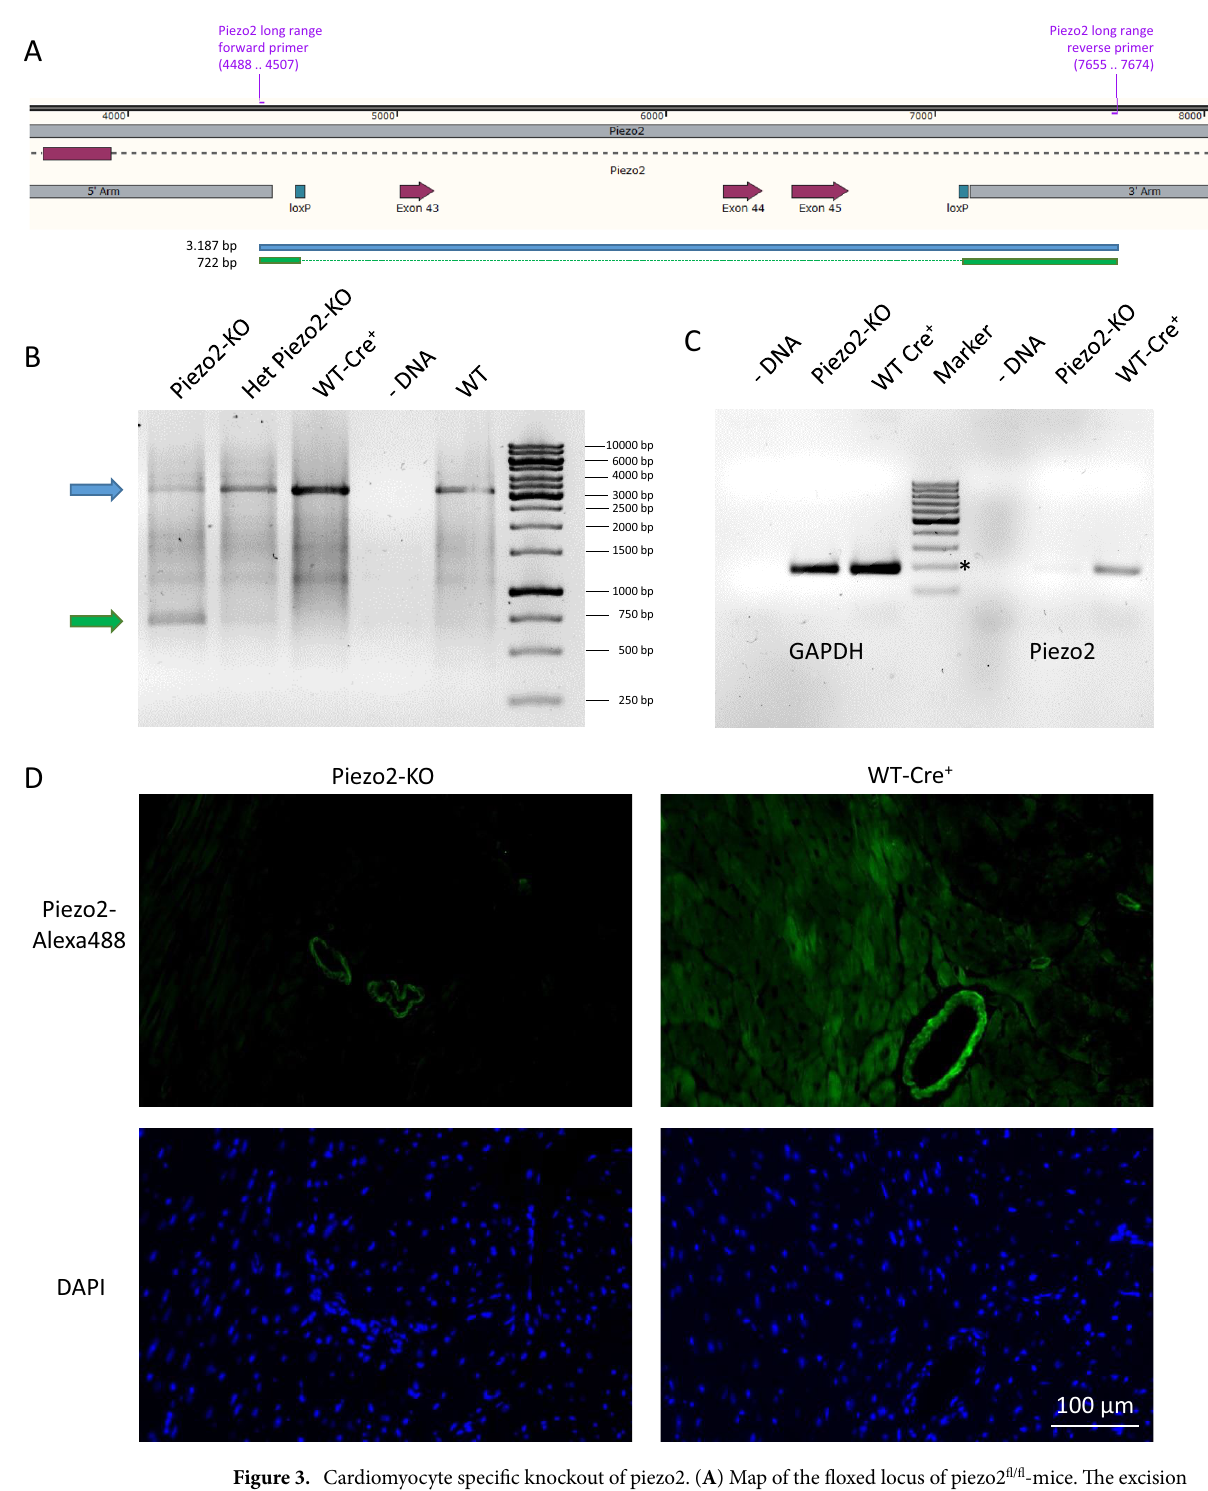
Figure 3. Cardiomyocyte specific knockout of piezo2. ( A ) Map of the floxed locus of piezo2 fl/fl -mice. The excision of the interloxP region containing exons 43–45 leads to a frameshift mutation and the creation of a stop codon in the piezo2 gene. Blue bar: 3187 bp PCR product without recombination; green bar: 722 bp PCR product after successful recombination. ( B ) PCR of DNA from unpurified left ventricular tissue (i.e., containing all cardiac cell types) with long-range primers (delineated in A ) followed by agarose gel separation. The blue and green arrows correspond to the sizes of the PCR products in ( A ). One representative lane for each mouse line is shown, overall n = 11 mice were analyzed. ( C ) Gel separation of the RT-PCR products from GAPDH or piezo2 mRNA obtained from purified cardiomyocytes. For each lane the PCR-products from the cardiomyocytes of one mouse heart were applied, for the quantification n = 3 per group were used. The molecular marker ranges from 100 to 1,000 bp in steps of 100. The GAPDH PCR product size was 185 bp, and the piezo2 PCR product size was 182 bp (*200 bp). ( D ) Immunofluorescence staining of Piezo2-KO and WT-Cre + -mice (green = piezo2, blue =